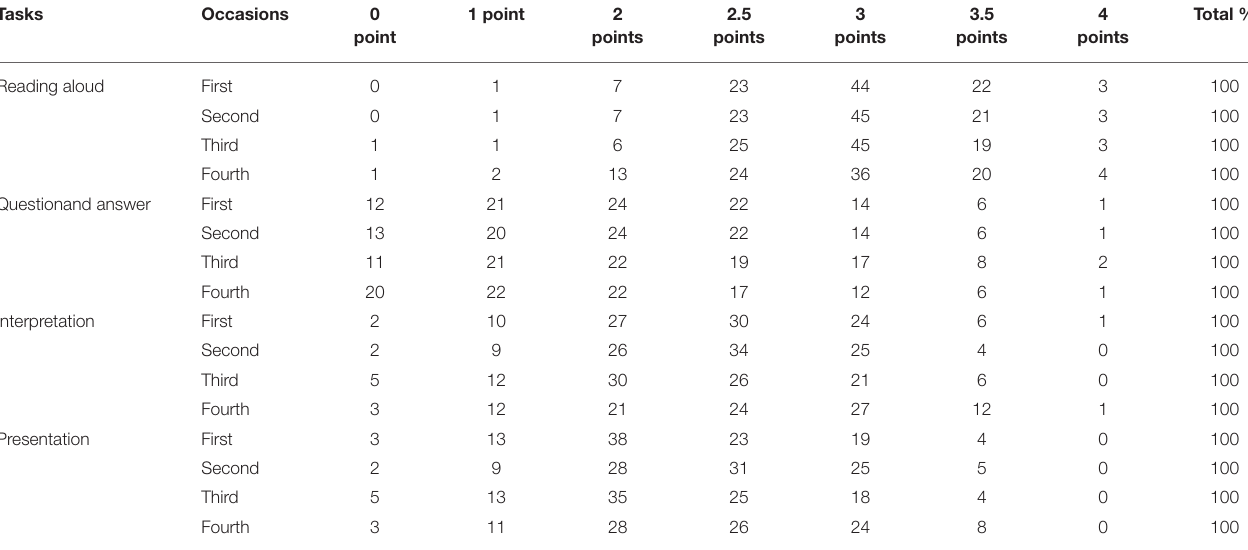
TABLE 3 | Longitudinal usage of each category of the four tasks (%). Tasks